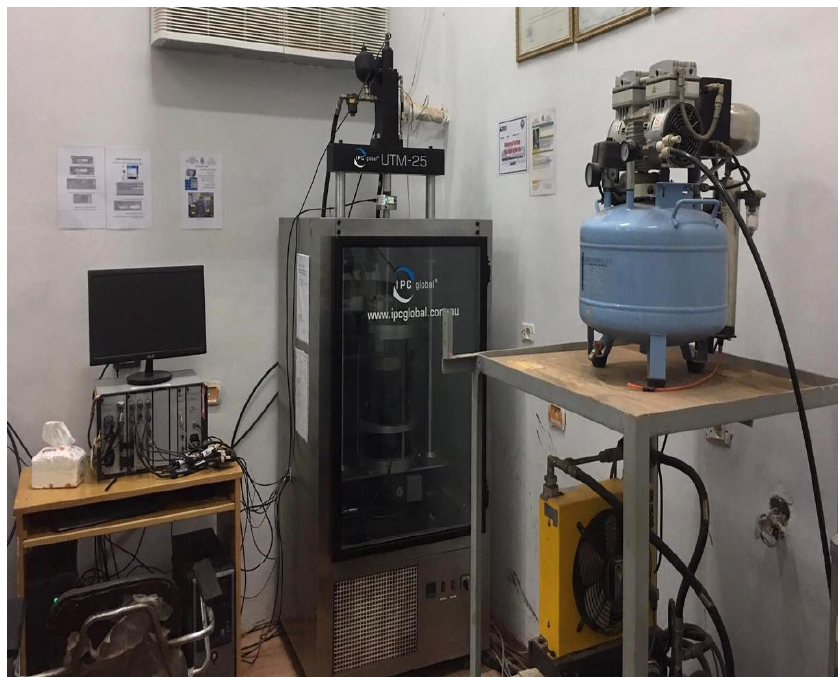
Figure 3. Universal testing machine (UT-25) for dynamic modulus and flow number testing.